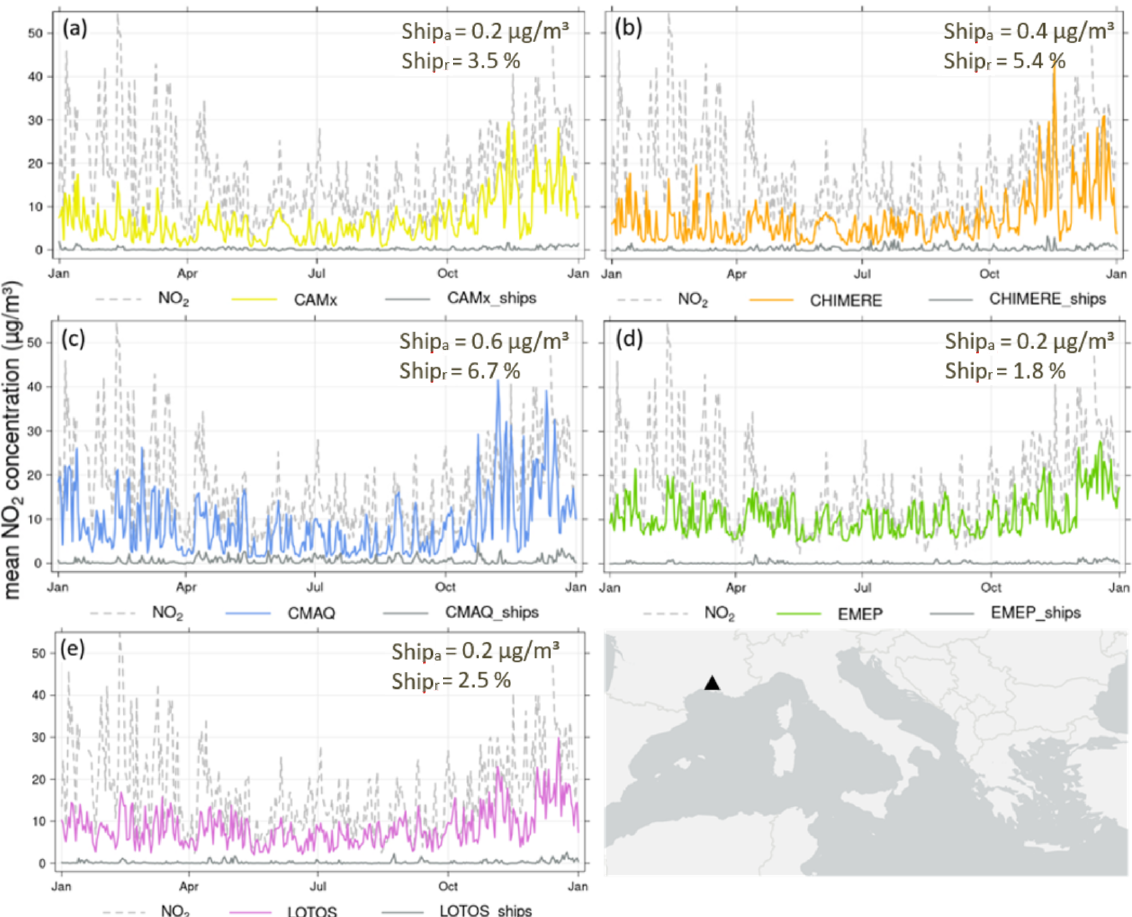
Figure C1. Time series with daily mean NO 2 concentrations in 2015 at station fr08614 in France. The black triangle on the map (bottom right) displays the location of the station. (a) CAMx; (b) CHIMERE; (c) CMAQ; (d) EMEP; (e) LOTOS-EUROS. Dashed gray line – measured data; colored lines – modeled data; gray line – modeled potential ship impact. Correlation between modeled and measured data for hourly total emission data for 2015: CAMx = 0 . 23; CHIMERE = 0 . 20; CMAQ = 0 . 60; EMEP = 0 . 02; LOTOS-EUROS = 0 . 65. Ship a : potential absolute ship impact; Ship r : potential relative ship impact of the respective